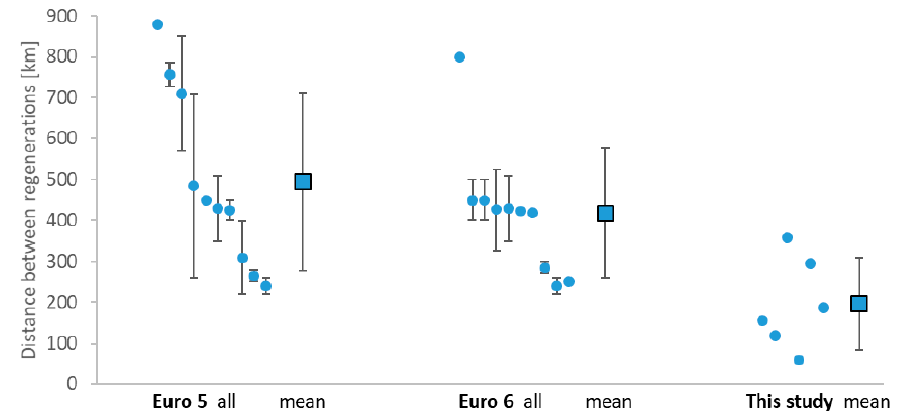
Figure 10. Distances between regeneration events of light-duty vehicles based on this study and the literature (details in text). Literature data are in descending order. The data of this study are in chronological order.